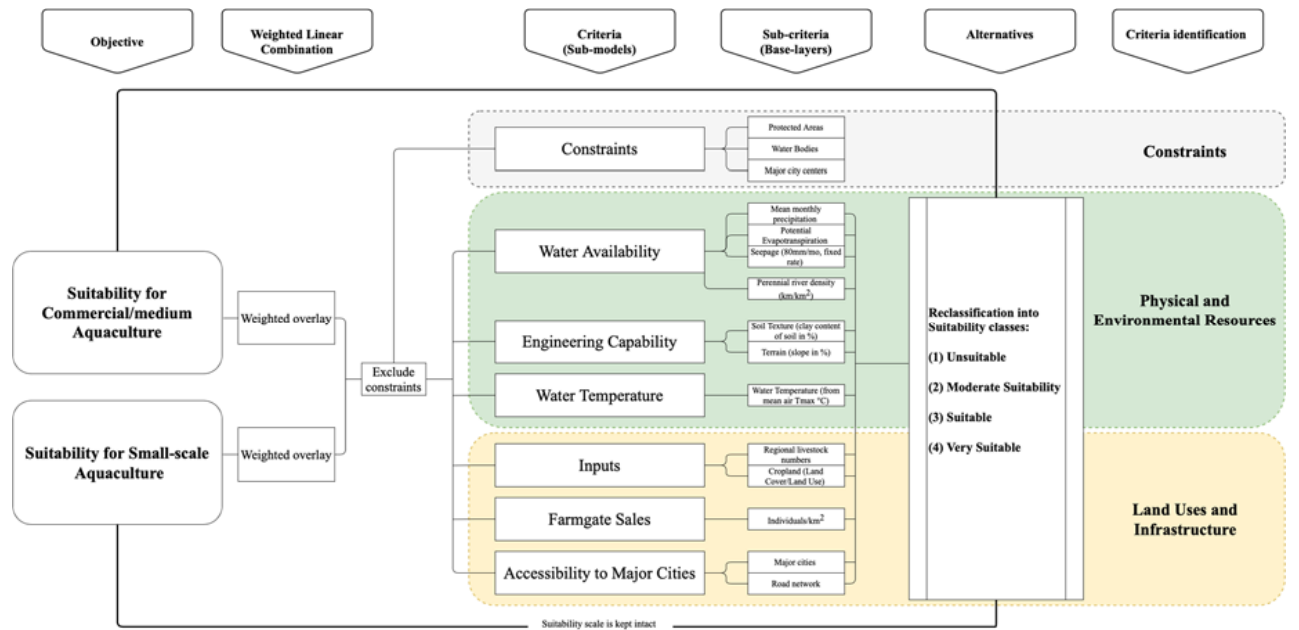
Figure 3. Structure of the GIS spatial